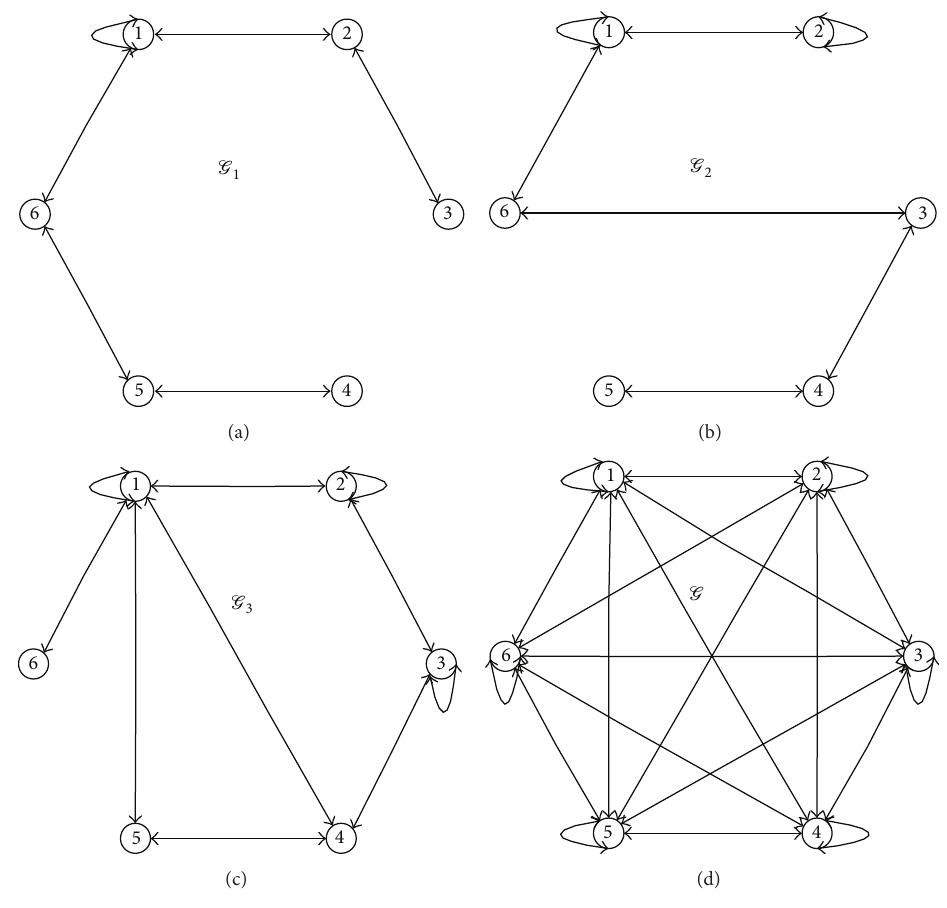
Figure 1: The communication topologies G 1 , G 2 , G 3 , and G